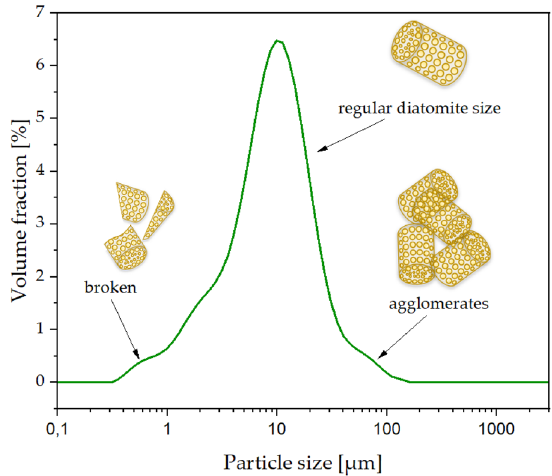
Figure 18. Particle size distribution of the original